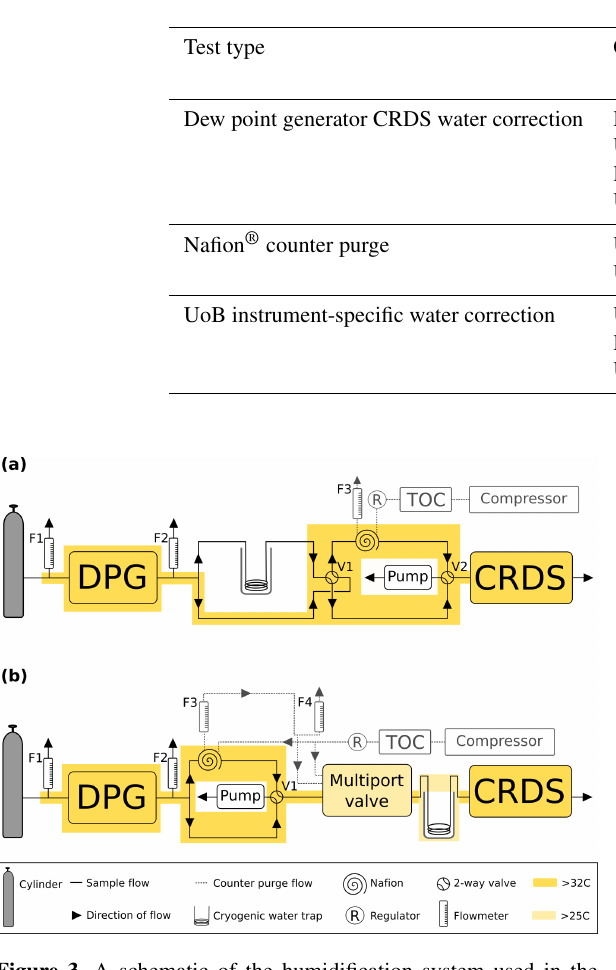
Table 2. The cylinders used during the dew point generator CRDS water correction, Nafion ® counter purge and UoB instrument-specific water tests. Most measurements were made in-house and only corrected for linear drift against a standard calibrated at WCC-EMPA, Düben- dorf, Switzerland, and hence are simply indicative of the expected mole fractions. Those marked ∗ were calibrated at GasLab MPI-BGC, Jena, Germany, and linked to the WMO x2007 CO 2 and x2004A CH 4 scales.